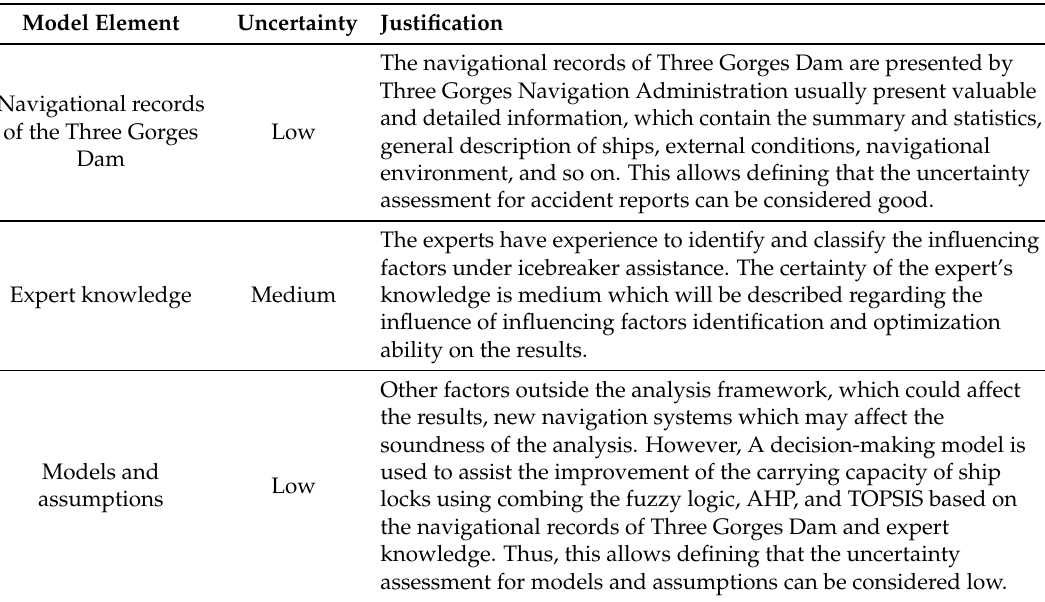
Table 14. the uncertainty assessment for the proposed